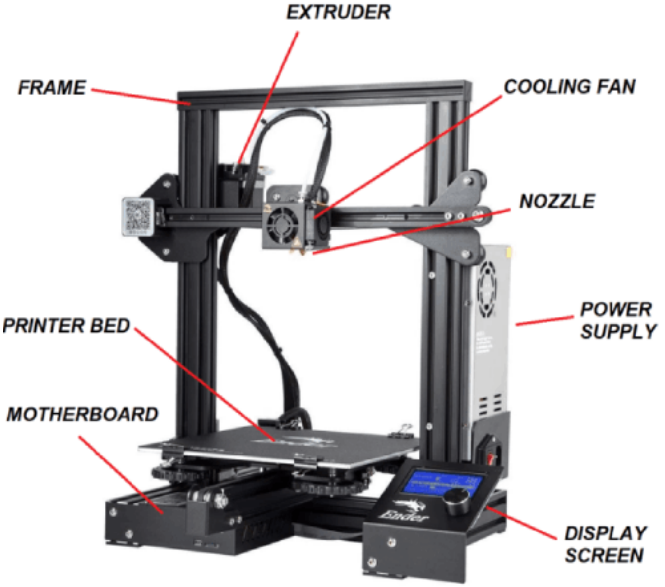
Figure 2. Creality Ender 3 V2 FDM 3D